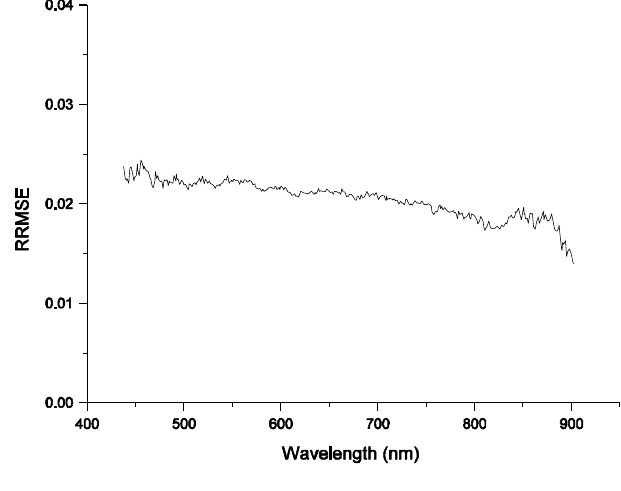
Figure 15. Linear fitting error measured by R-RMSE for each channel (band) of the